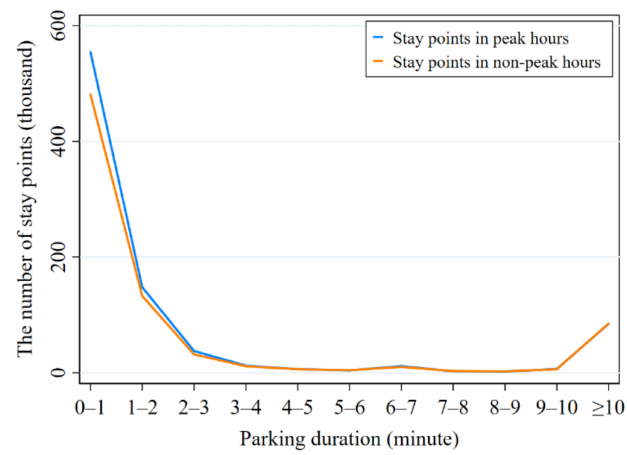
Figure 5. The quantitative distribution of stay points in di ff erent parking